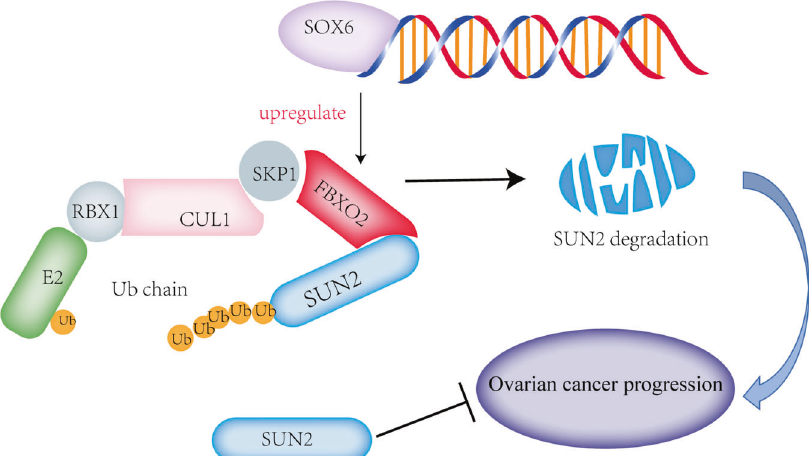
Fig. 7 Working model. In this working model, we show that the transcription factor SOX6 promoted FBXO2 expression in OV. Abnormally highly expressed FBXO2 recognized and targeted glycosylated SUN2 protein for ubiquitination-depended degradation to promote the development of